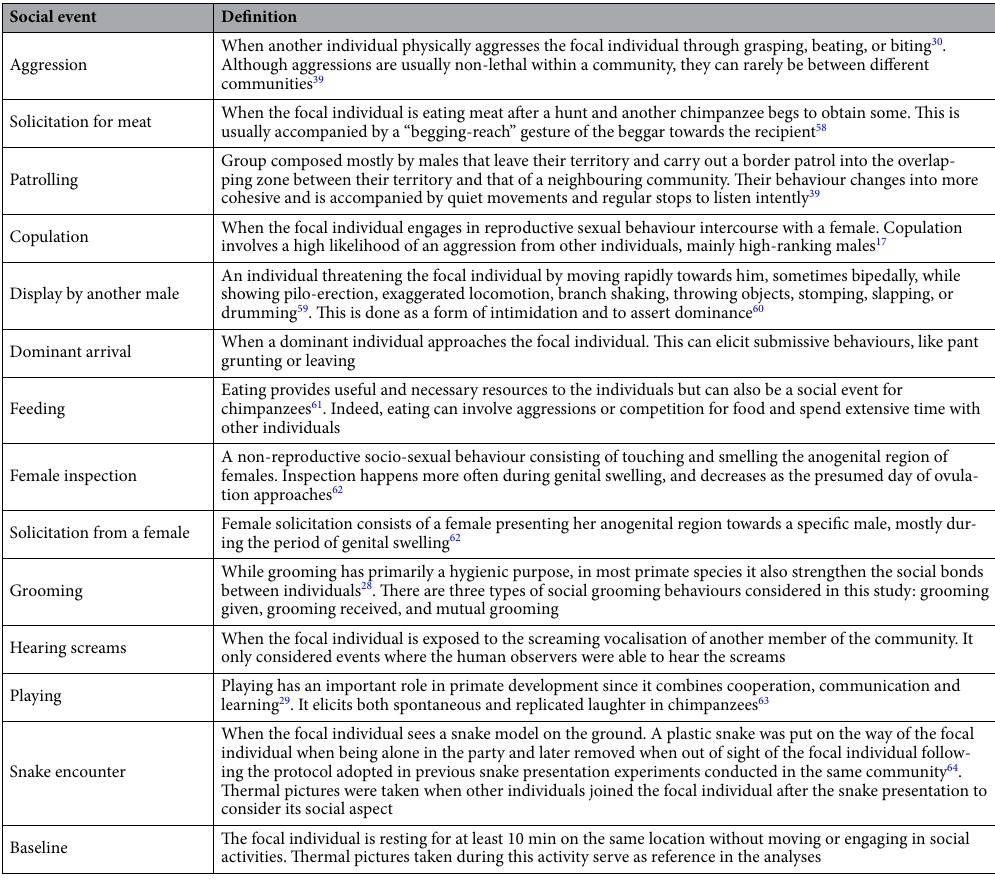
Table 1. List of social events of interest with respective definitions.